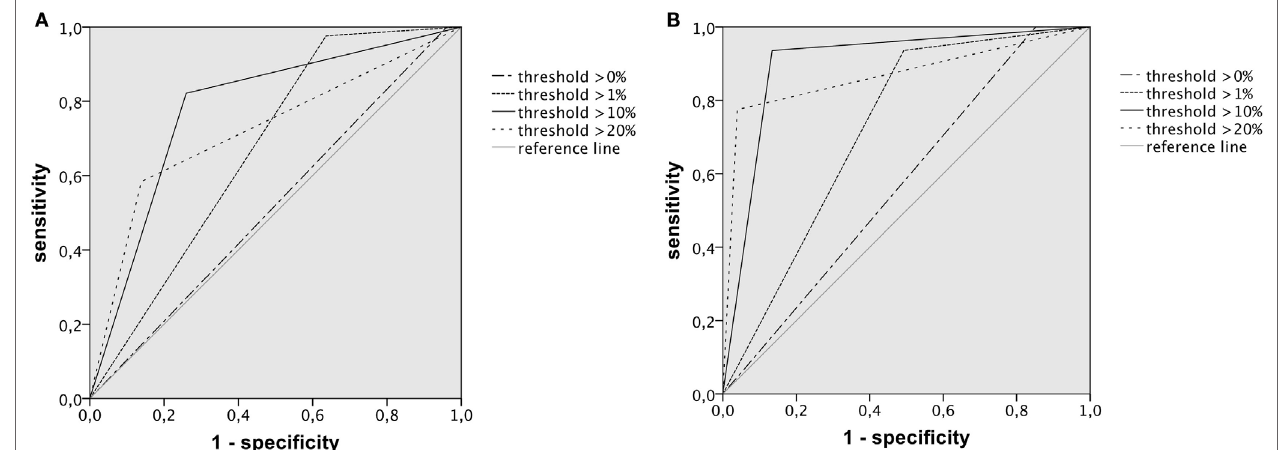
FigUre 4 | ROC curves illustrating the performance of dichotomized Alberta Stroke Program Early Computed Tomography Score (ASPECTS) determined by automated rating approaches for prediction of the respective visual cut-off; (a) for ASPECTS ≤ 7, AUC was highest for the > 10% relative lesion load (RLL) threshold with 0.781, 95% confidence interval of 0.723–0.839; (B) for ASPECTS ≤ 5, AUC was highest for the 10% RLL threshold with 0.901, 95% confidence interval of 0.845–0.956.